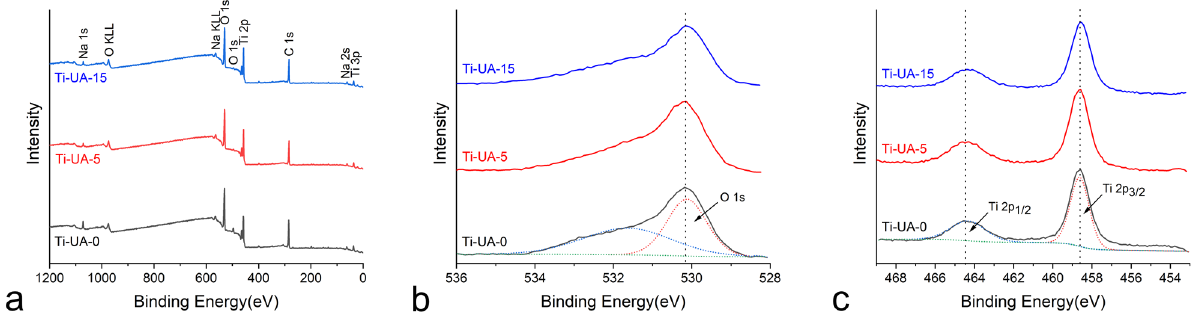
Fig. 2 XPS spectra of different titanium samples (( a ) survey spectra of the samples; ( b ) high-resolution spectra of O 1 s on the samples; ( c ) high- resolution spectra of Ti 2p on the samples)